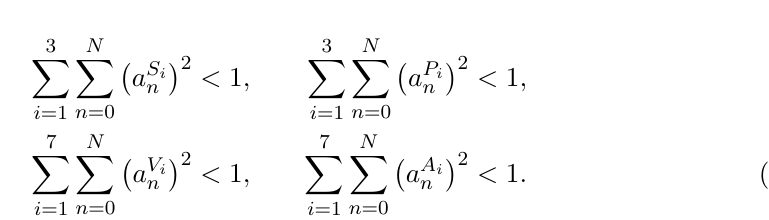
and 1 (cid:0) and (cid:31) , 0 + 0 (cid:0)